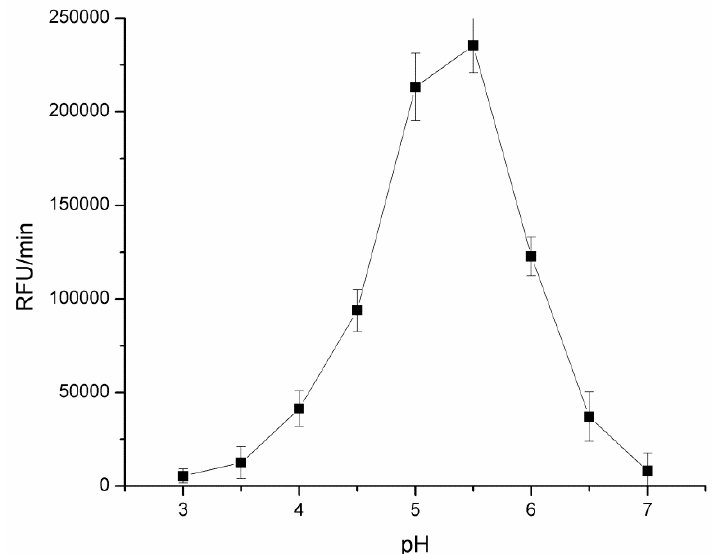
Figure 1. Dependence of fluorescence signal (RFU/min) on pH in 0.1 M sodium phosphate buffer with 10 mM lactose, 0.1 mM resazurin and 0.29 IU/mL of CDH enzyme. Fluorescence measured at ex/em 540/590